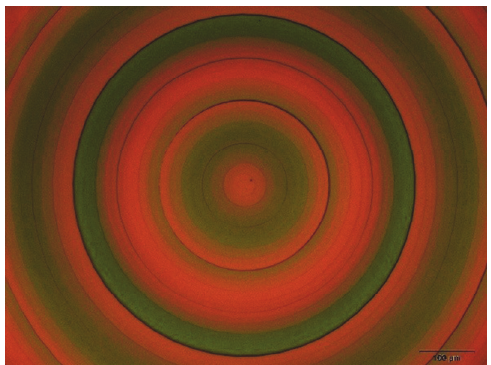
Fig. 1. Optical image of an axicon of order zero with 32 levels